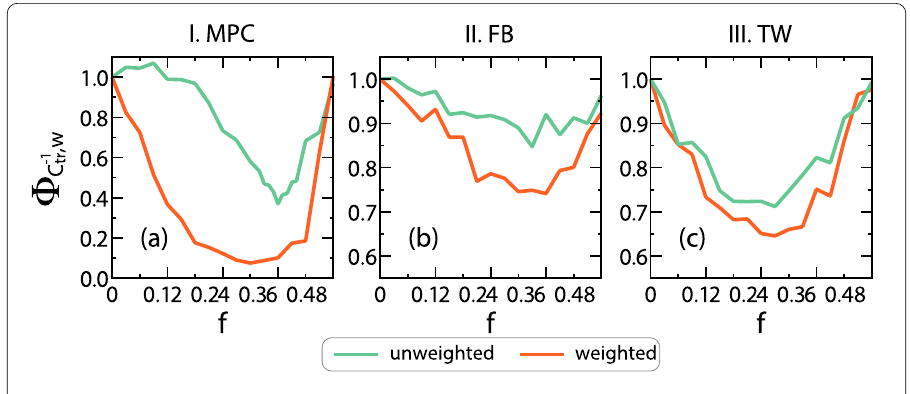
Figure 5 The (cid:7) ( f ) = R ( δ )/ R O , w ( δ ) ratio of endemic recovered population sizes of ( O , C –1 tr ) and ( O , w ) C –1 tr , w O , C –1 tr strategies as a function of controlled f fractions of links. Calculations are repeated in unweighted (green) and weighted (red) networks of ( a ) MPC, ( b ) FB, and ( c ) TW. Results are obtained averaging over SIR spreading processes with parameters β = 0.25, μ = 0.1 and δ = 0.01 initiated from 1000 random